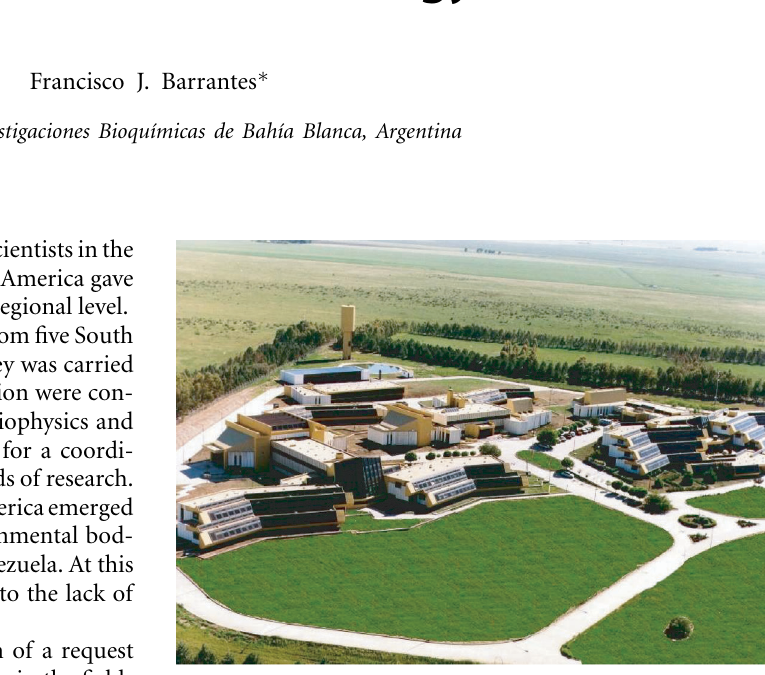
Figure 1: Aerial view of the Institute for Biochemical Research / UNESCO Chair in Bahia Blanca, Argentina.